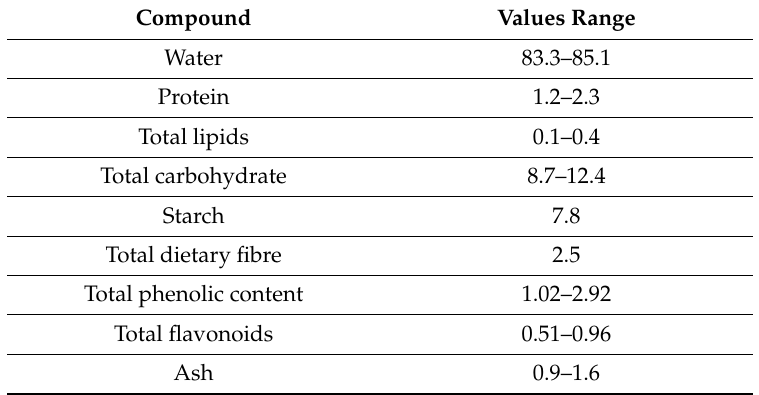
Table 1. Chemical composition of raw potato peel (PP), g per 100 g (Adapted from: Javed et al., 2019